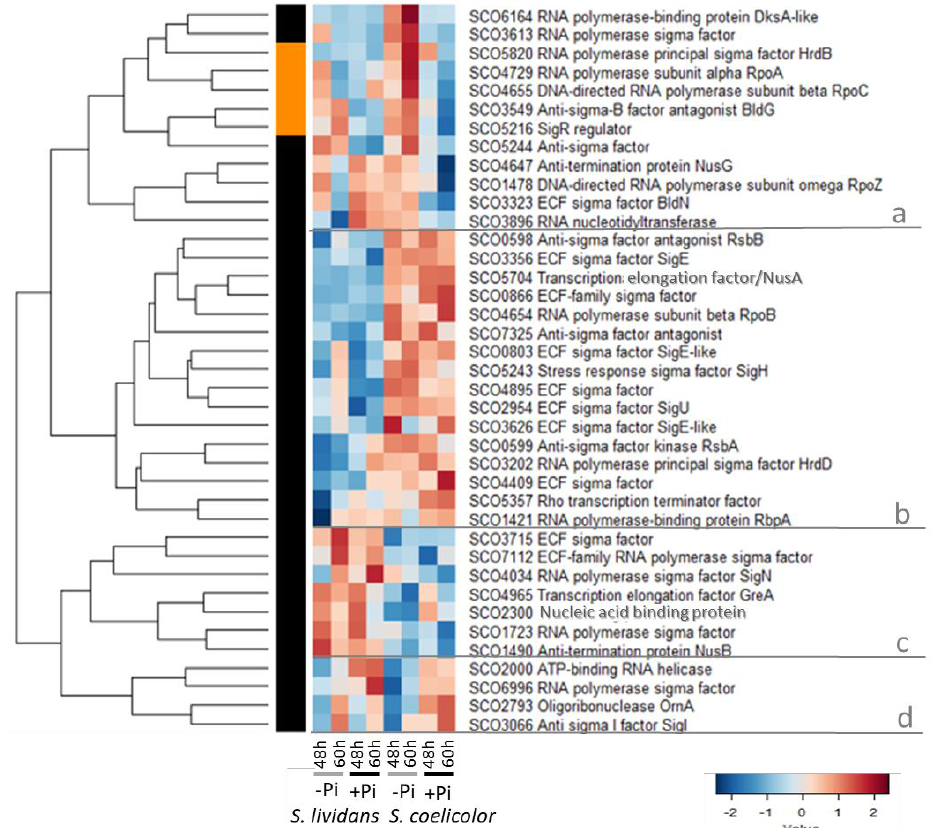
Figure 1. Heatmap representation of the abundance of components of the transcriptional apparatus of SL and SC that can be divided in 4 sub-clusters a, b, c and d. Cluster a includes 12 proteins rather more abundant in SC than in SL in Pi limitation especially at 60 h. Cluster b includes 16 proteins more abundant in SC than in SL in both Pi conditions. Cluster c includes 7 proteins more abundant in SL than in SC in both Pi conditions. Cluster d includes 4 proteins more abundant in Pi proficiency than in Pi limitation in both strains but mainly at 60